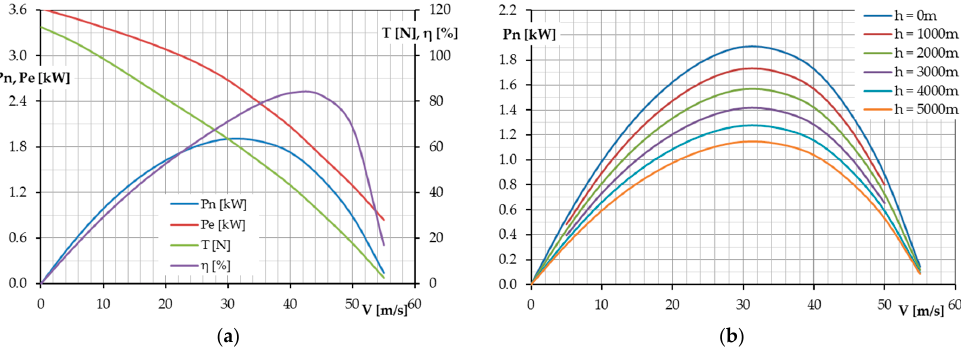
Figure 3. ( a ) Propulsion unit characteristics: P e —motor electric power, P N —effective power, η —total efficiency, T —thrust; and ( b ) power available versus airspeed for several flight altitudes.